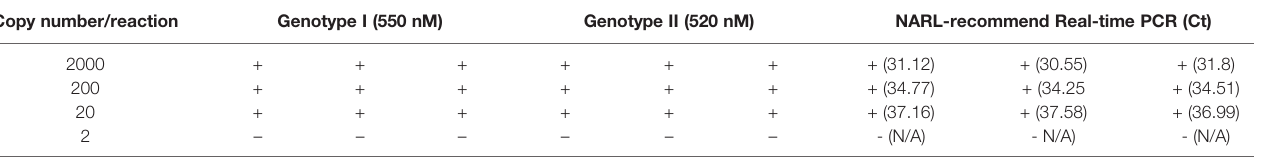
TABLE 2 | Sensitivity of the duplex iiPCR.